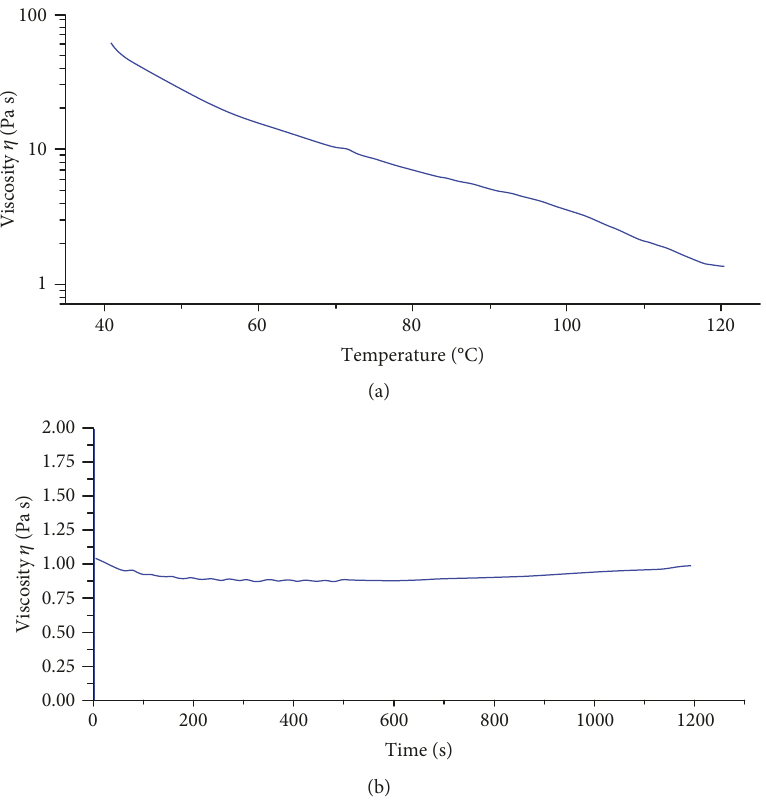
Figure 1: (a) Viscosity vs. temperature and (b) evaluation of the resin ’ s pot